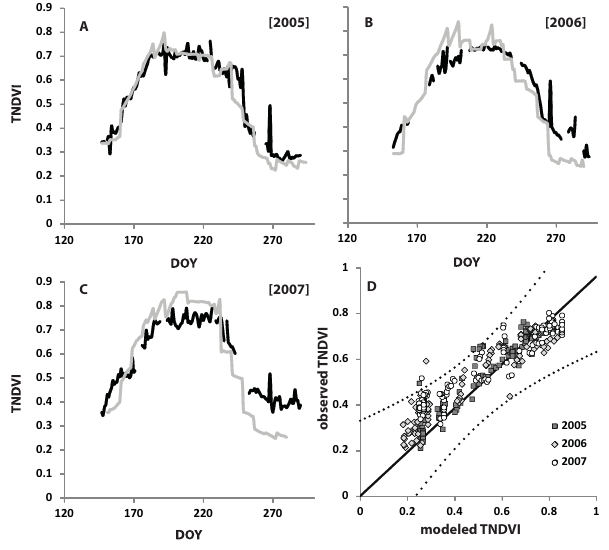
Fig. 3. Observed and modeled TNDVI dynamics obtained through data assimilation for (A) 2005, (B) 2006, (C) 2007 growing seasons at Bondville sites (soybean and maize mixed in one MODIS pixel). Segment (D) shows fitted regression line with 0 intercept and slope of 0.98 derived on 3 years of temporarily matched estimates and observations ( n = 415; r 2 = 0 . 90, RMSE = 0.082).